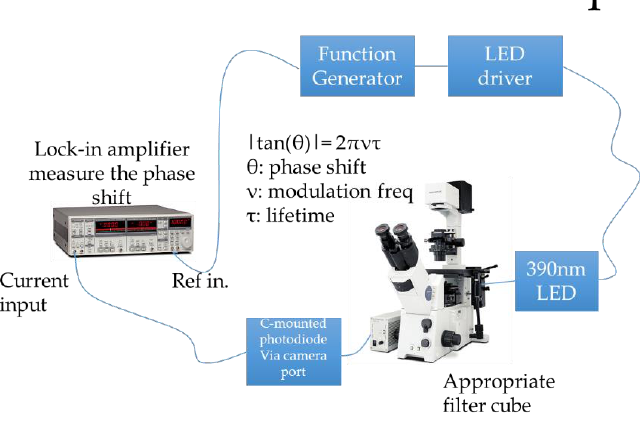
Figure A1. Photobleaching independent measurement setup for the phosphorescent lifetime of PtTFPP oxygen sensitive dye. The phase shift between the signal from the photodiode and the source excitation wavelength can be used to calculate the lifetime.